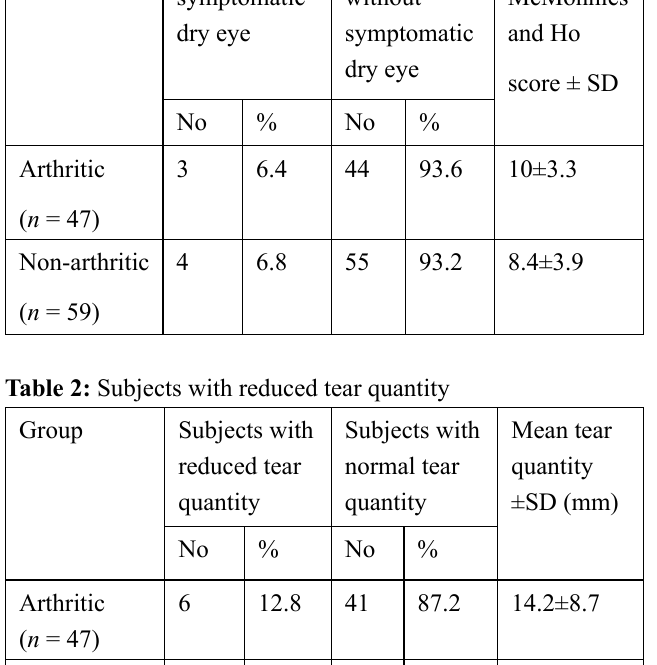
Table 1: Subjects with symptomatic dry eyes Group Subjects with symptomatic dry eye